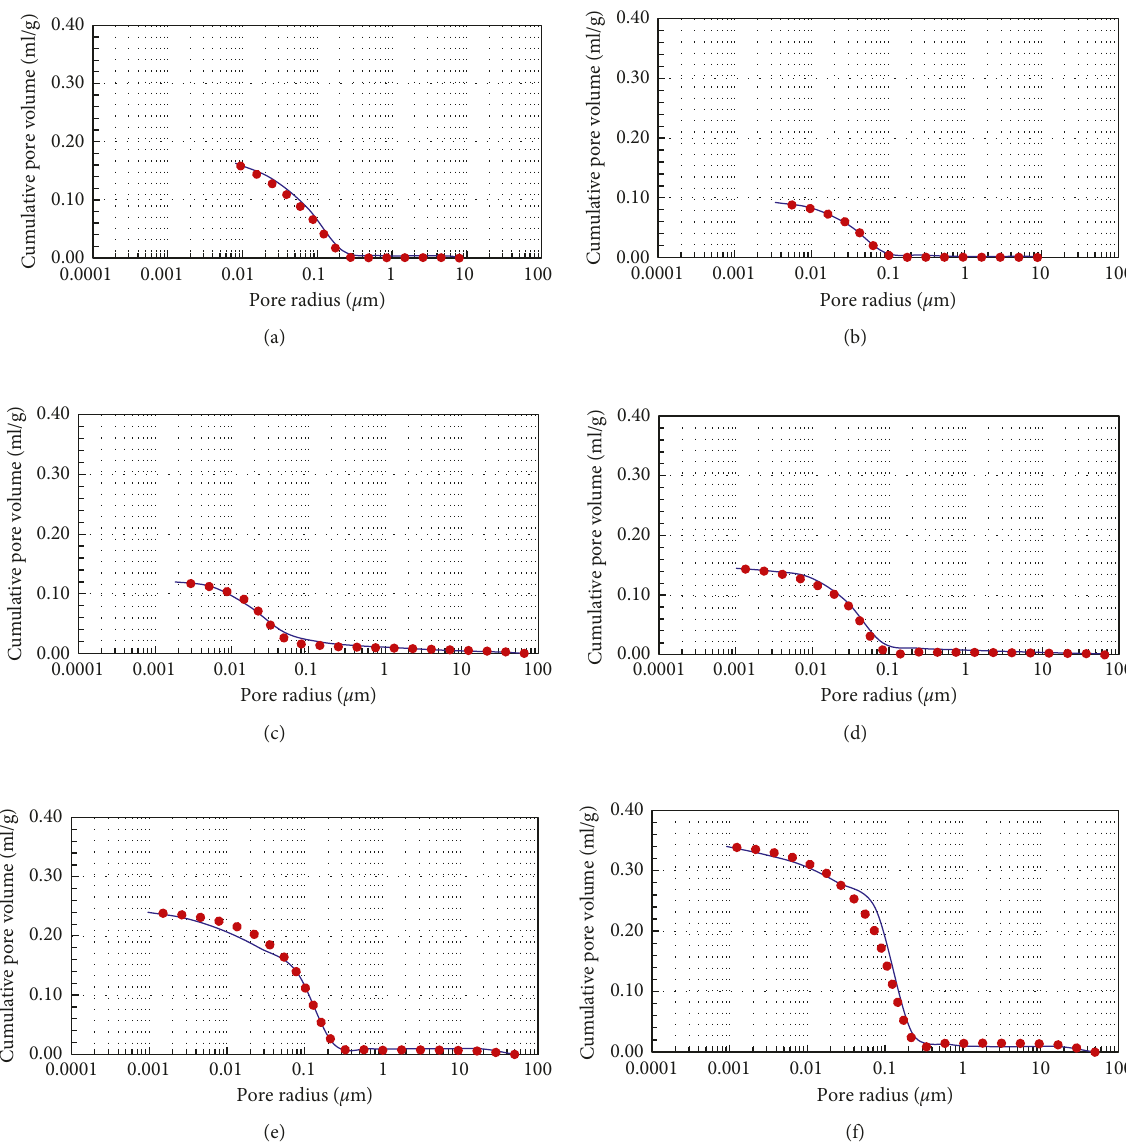
Figure 3: Comparison between experimental (continuous line) and IFU (dot line) pore cumulative curves: B-2 (a), B-3 (b), C-2 (c), C-4 (d), D-3 (e), and D-4